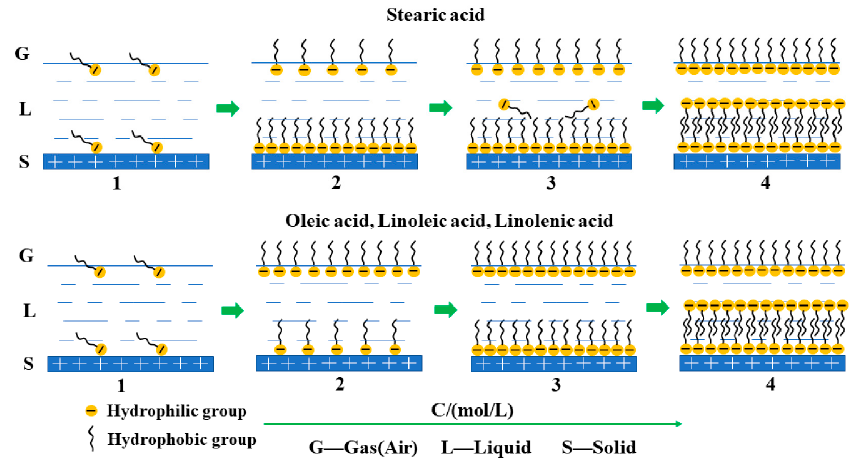
Figure 10. Adsorption schematic model of fatty acid on the rhodochrosite surface.